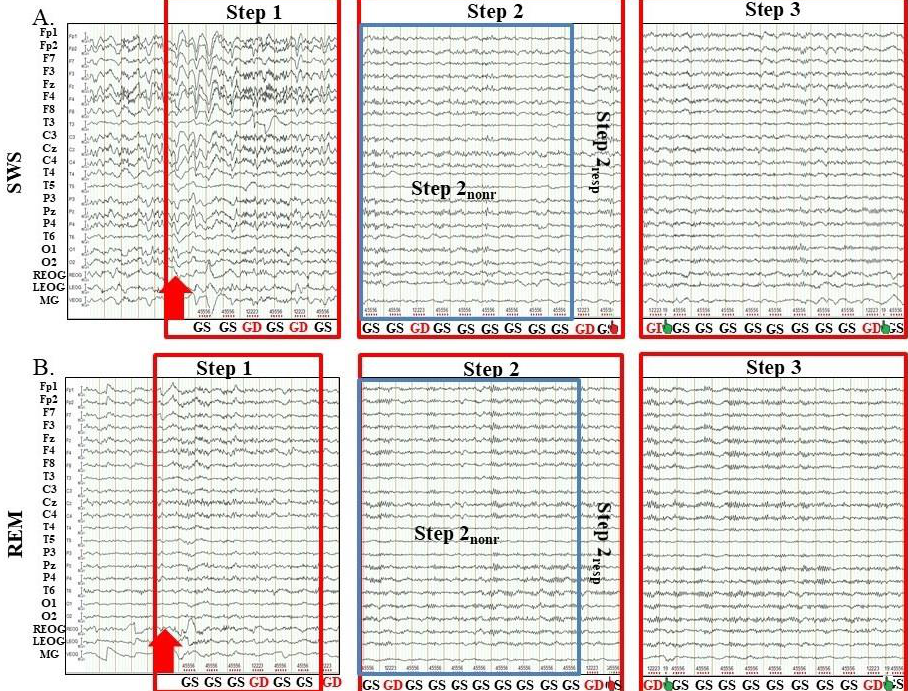
Figure 1. Examples of Steps of awakenings in the sessions with awakening from slow-wave sleep and rapid eye movement sleep. SWS, slow-wave sleep; REM, rapid eye movement sleep; Step 1, period of awakening when delta or theta prevail in EEG, the motor response is absent; Step 2, period of awakening when alpha prevails in EEG, the motor response is either absent or slow; Step 2 nonr , period of awakening when alpha prevails in EEG, the motor response is absent; Step 2 resp , period of awakening when alpha prevails in EEG, the motor response is slow; Step 3, period of awakening when alpha prevails in EEG, the motor response is accurate and timely; red arrow, the start of alarm sound; GS, global standard; GD, global deviant; the hand, motor response; the red hand, the motor response is slow; the green hand, the motor response is accurate and